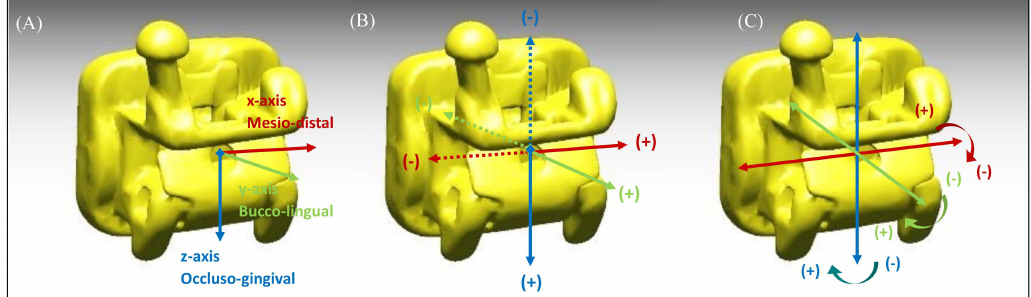
Figure 7. Three-dimensional coordinate system. The origin of the coordinate system was set to coincide with the center point of the bracket base. ( A ) The mesiodistal axis ( x -axis) was to be parallel to the bracket slot (red color). The buccolingual direction ( y -axis) was formed by drawing a normal line based on the lingual surface of the bracket slot (green color). The z -axis (occlusogingival direction) was determined to be perpendicular to the plane of the other two axes (blue color). ( B ) Measurement of linear bracket displacements. Positive values in each direction indicate mesial in the x -axis, occlusal in the y -axis, and buccal in the z -axis. ( C ) The values of angular discrepancy can be calculated between the coordinate vectors of the control group (virtual bracket position) and the experimental group (post-transfer bracket position) formed according to the preceding description. The rotation of the bracket with respect to the x -axis represents torque, the y -axis represents angulation, and the z -axis represents rotation. Positive values represent crown buccal torque, mesial root tip, and mesiobuccal